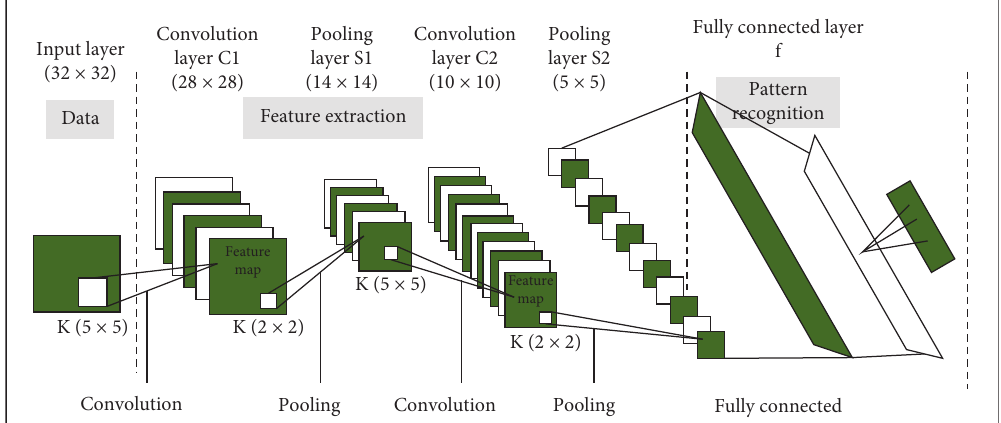
Figure 5: Typical convolutional neural network structure